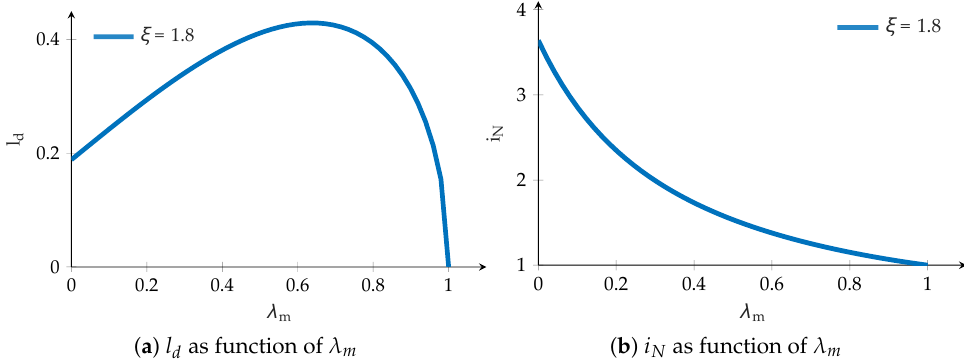
Figure 2. Normalized l d and i N versus rotor flux linkage ( λ m for IPM motor, λ HE , max for HEPM motor) and ξ =